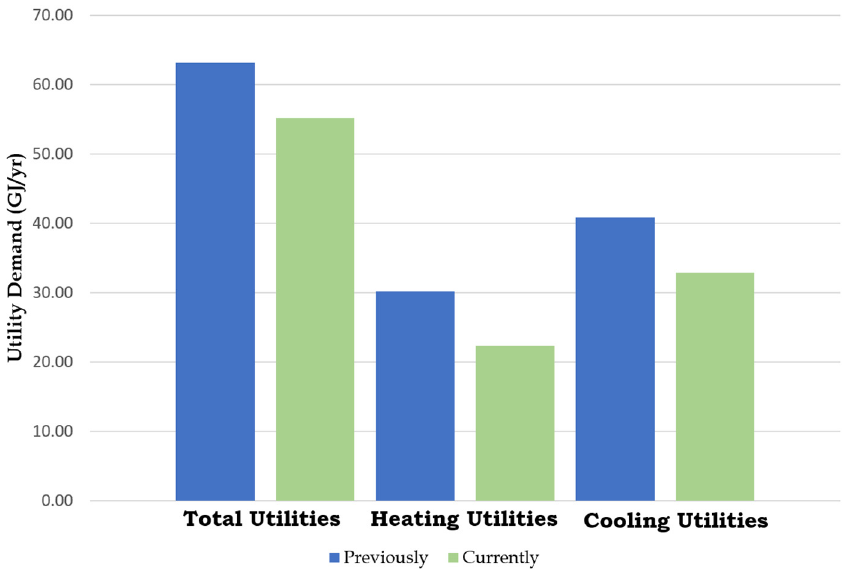
Figure 3. Heat integration outcome for the developed process. The blue columns in Figure 3 represent the utility demand before the heat integration, while the green columns represent the current value of the utility demand in the MIBK process after heat integration. In addition, the figure is divided into three sections, starting from the total utility demand, including the combined heating and cooling utilities, then the heating utility in the middle, while the cooling utility is placed on the right side. The process was re-simulated after the heat integration using CHEMCAD v.7.1. The devel- oped flowsheet after heat integration is shown in Figure 4. The material balances for the key streams of the developed MIBK process are shown in Table 2.